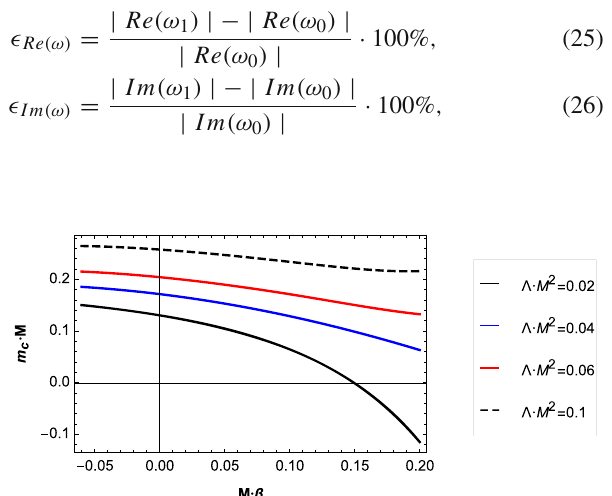
Fig. 6 The behavior of the m c M as a function of M β for different values of (cid:6) M 2 with n PS =